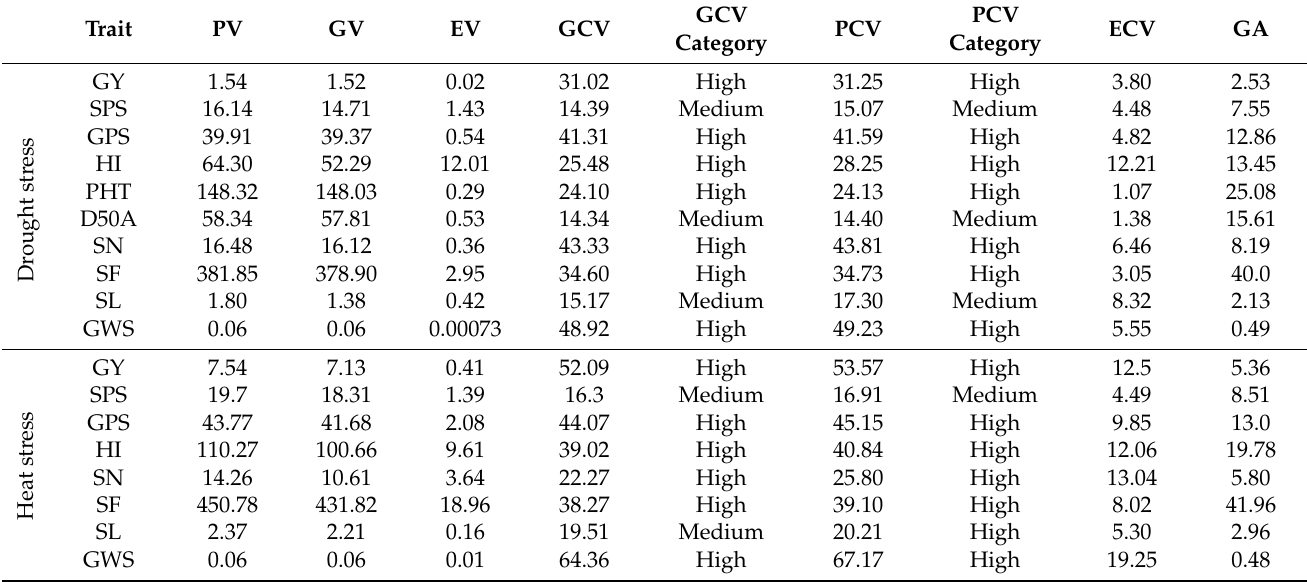
Table 3. Genetic variability analysis for various agronomic traits and yield components of the 46 wheat genotypes grown under drought and heat-stressed